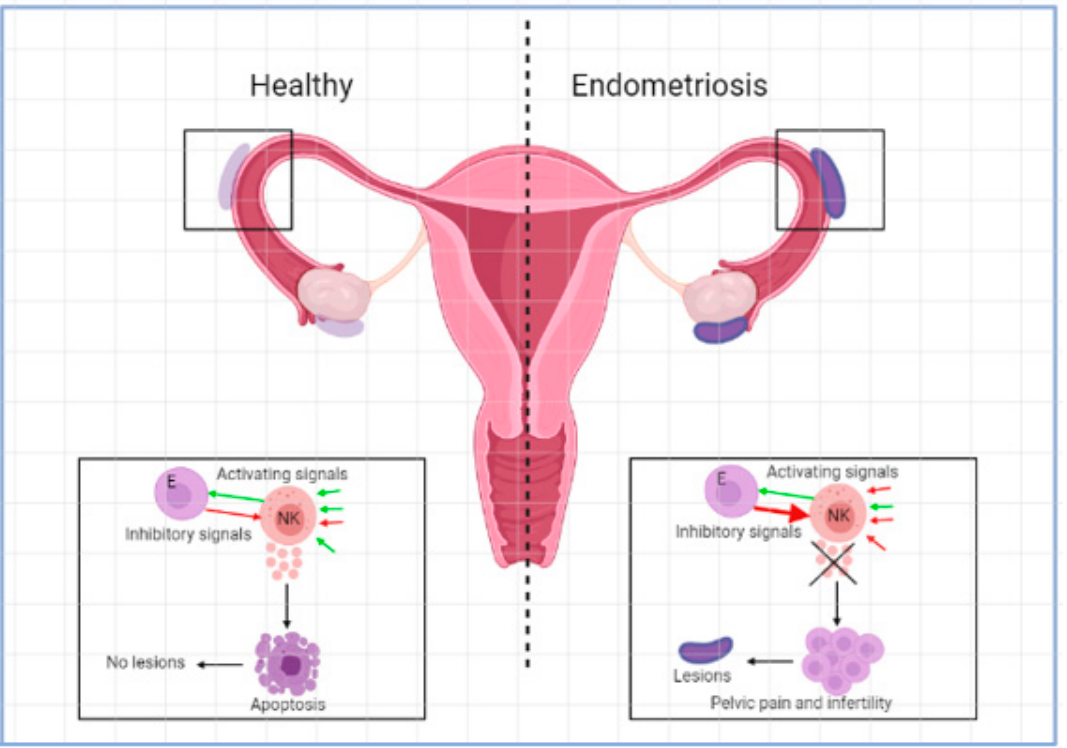
Figure 1. Activating and inhibitory signals in NK cell microenvironment in the development of en- dometriosis.